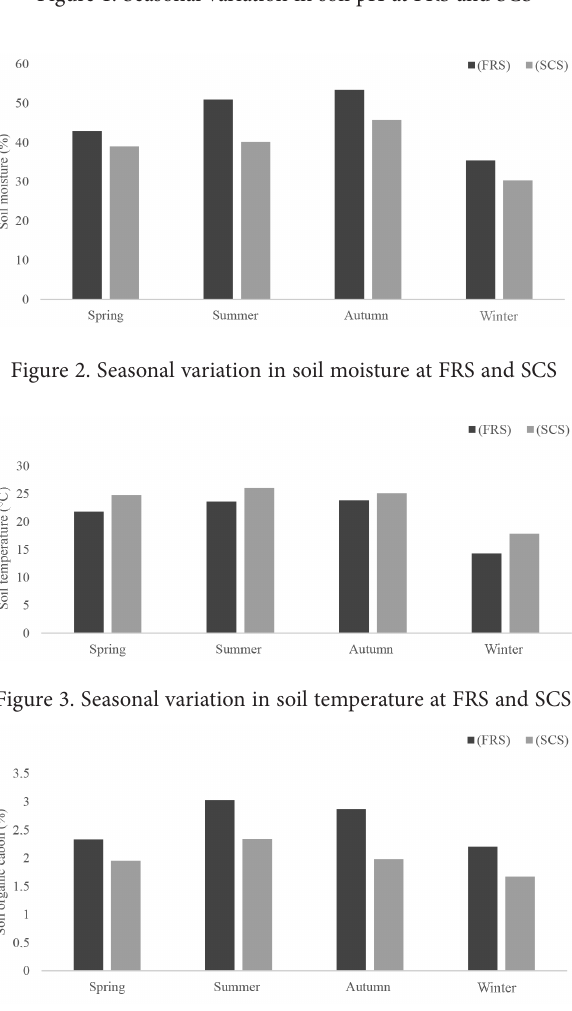
Figure 1. Seasonal variation in soil pH at FRS and SCS